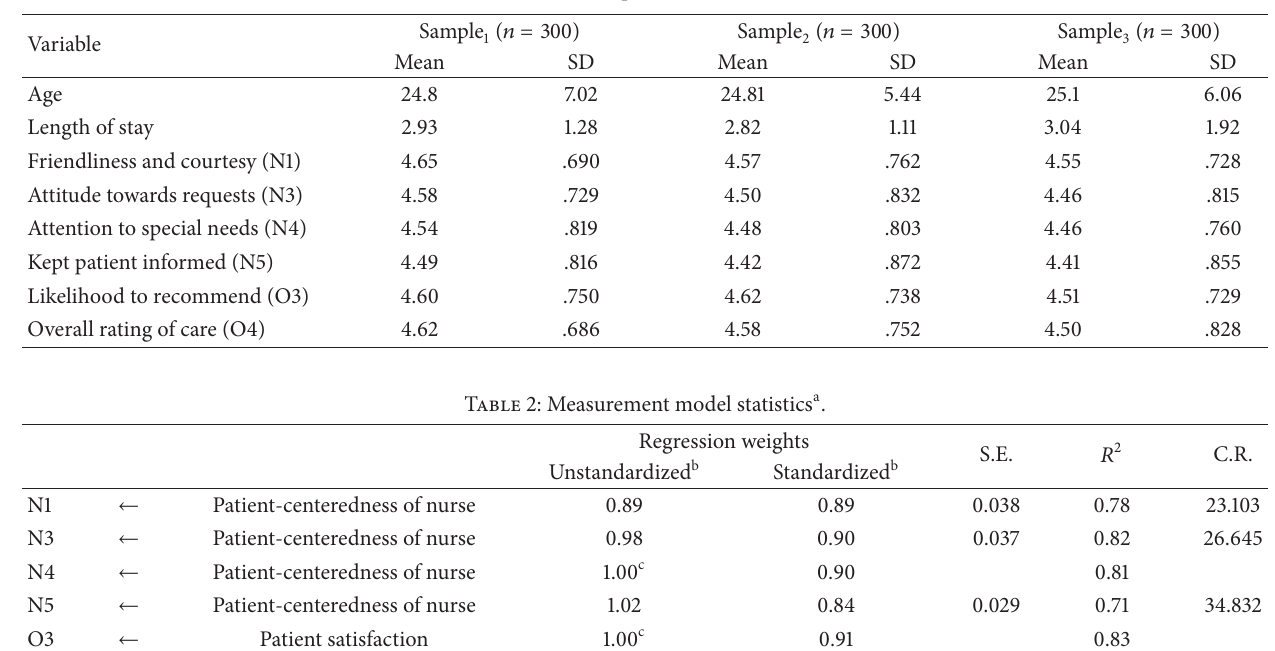
Table 1: Sample characteristics.